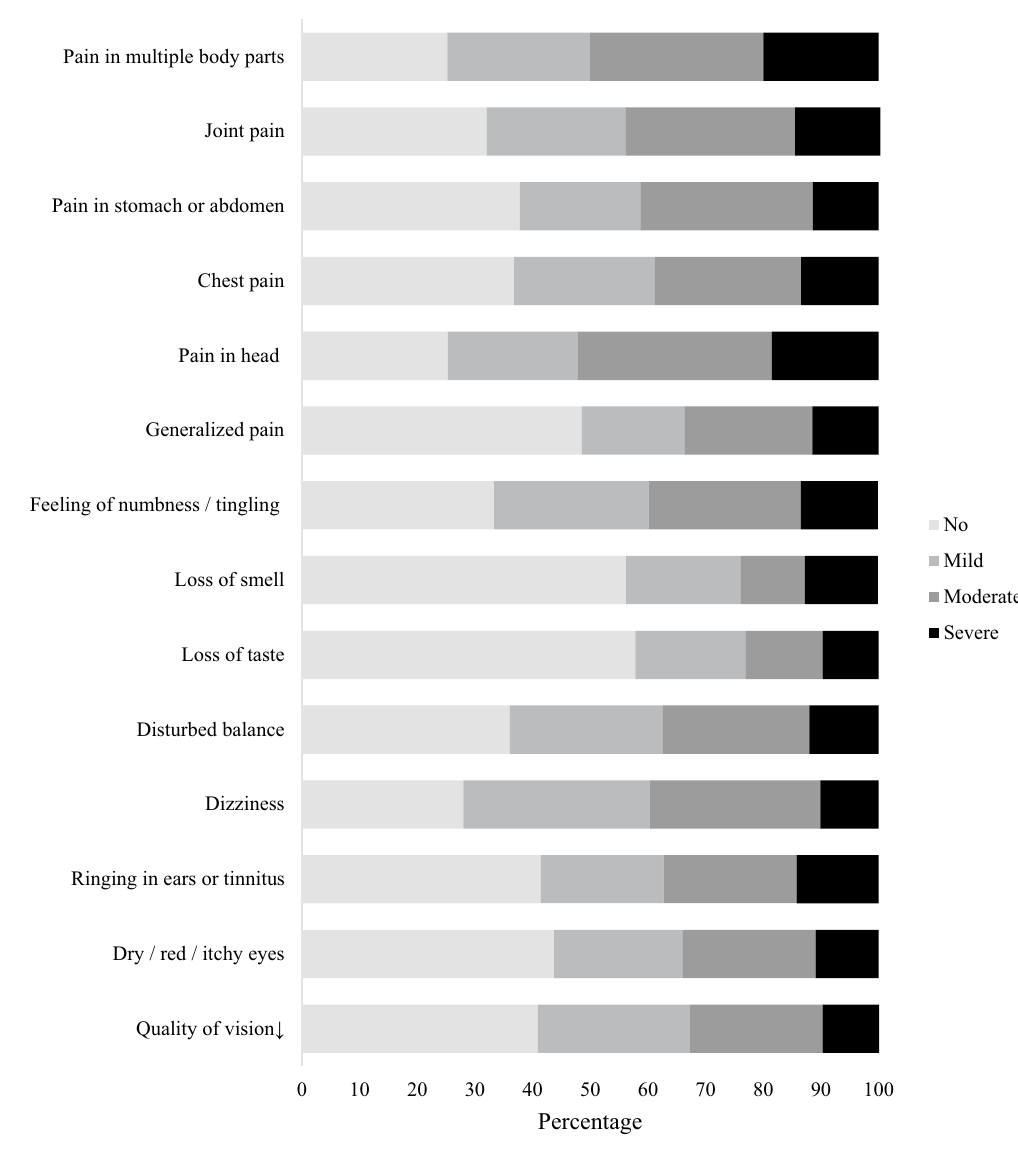
Figure 2. Proportions reporting impairments in sensory functions and